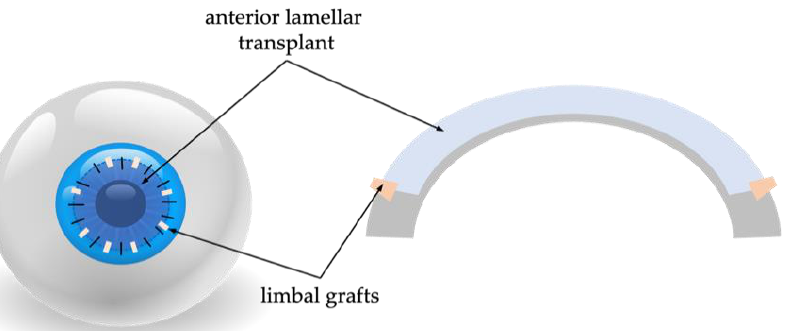
Figure 8. Schematic representation of the main steps of G-SLET in unilateral LSCD. After 360 degrees of peritomy and excision of the fibrovascular pannus, cornea polishing is performed with the diamond-dusted burr. 8 symmetrical radial non-perforating incisions are made for implantation of mini-limbal grafts taken from the upper corneal limbus of the healthy eye. Surgery is finished with suturing an amniotic membrane overlay.